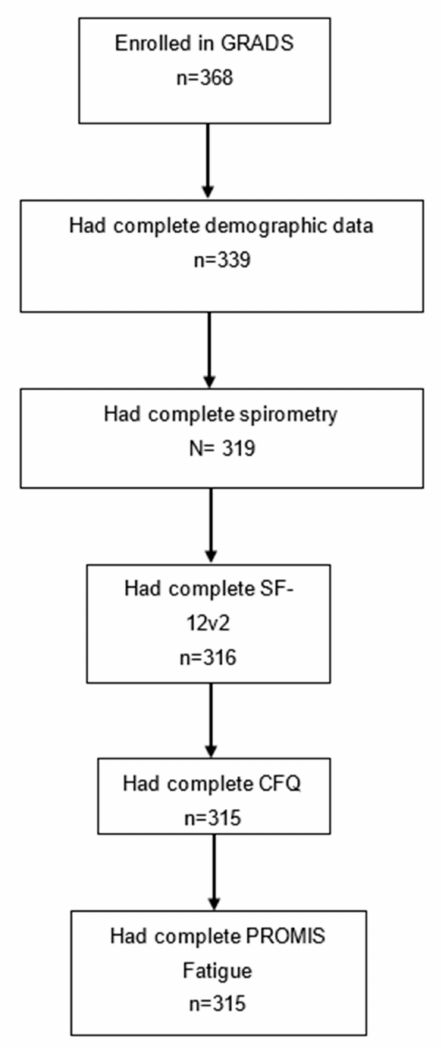
Figure 1. Consort diagram of GRADS participants included in the current analysis based on available